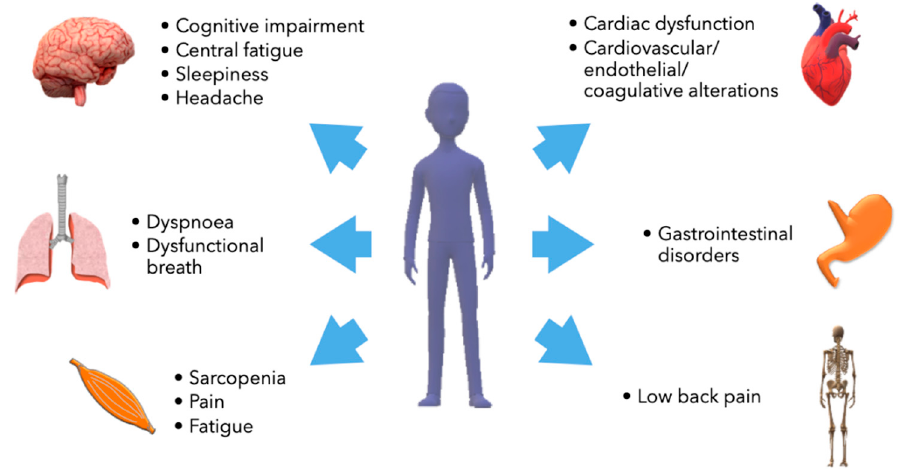
Figure 1. Main organs involved in long COVID-19.